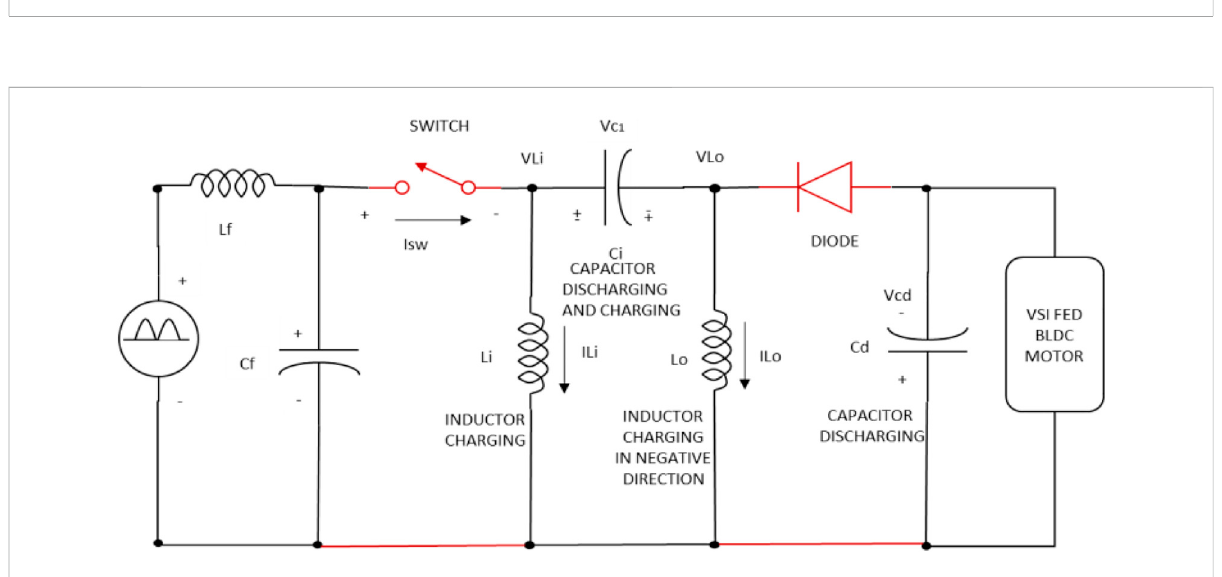
FIGURE 7 Mode 4 of modi fi ed Zeta